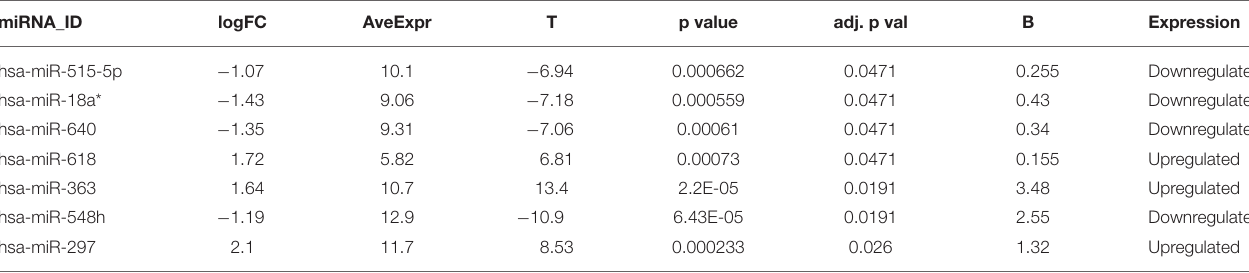
TABLE 1 | Differentially expressed miRNAs in HUVEC cells treated with 10 µ M simvastatin for 24h. miRNA_ID logFC AveExpr T p value adj. p val B